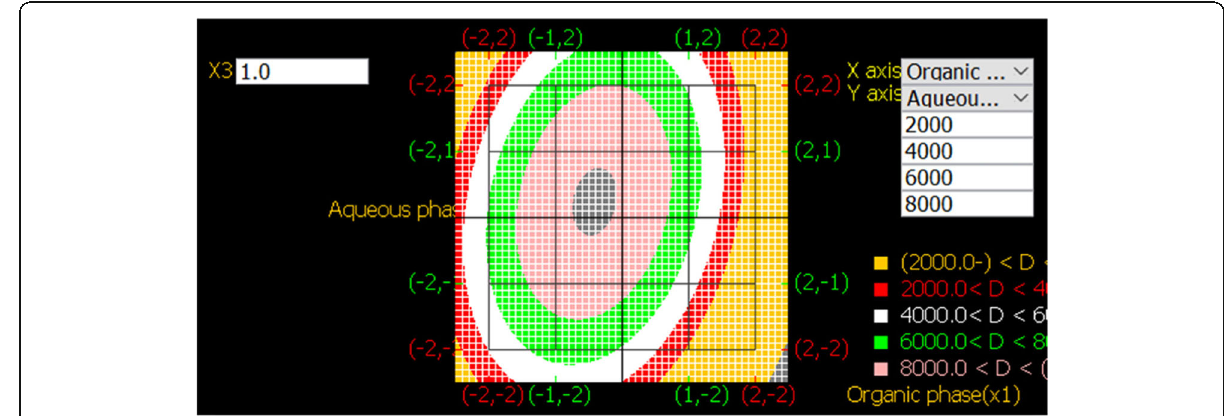
Fig. 1 Contour plot of sofosbuvir at 1.0 ml flow